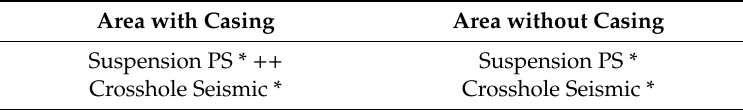
Table 1. The preliminary selected list of downhole geophysical